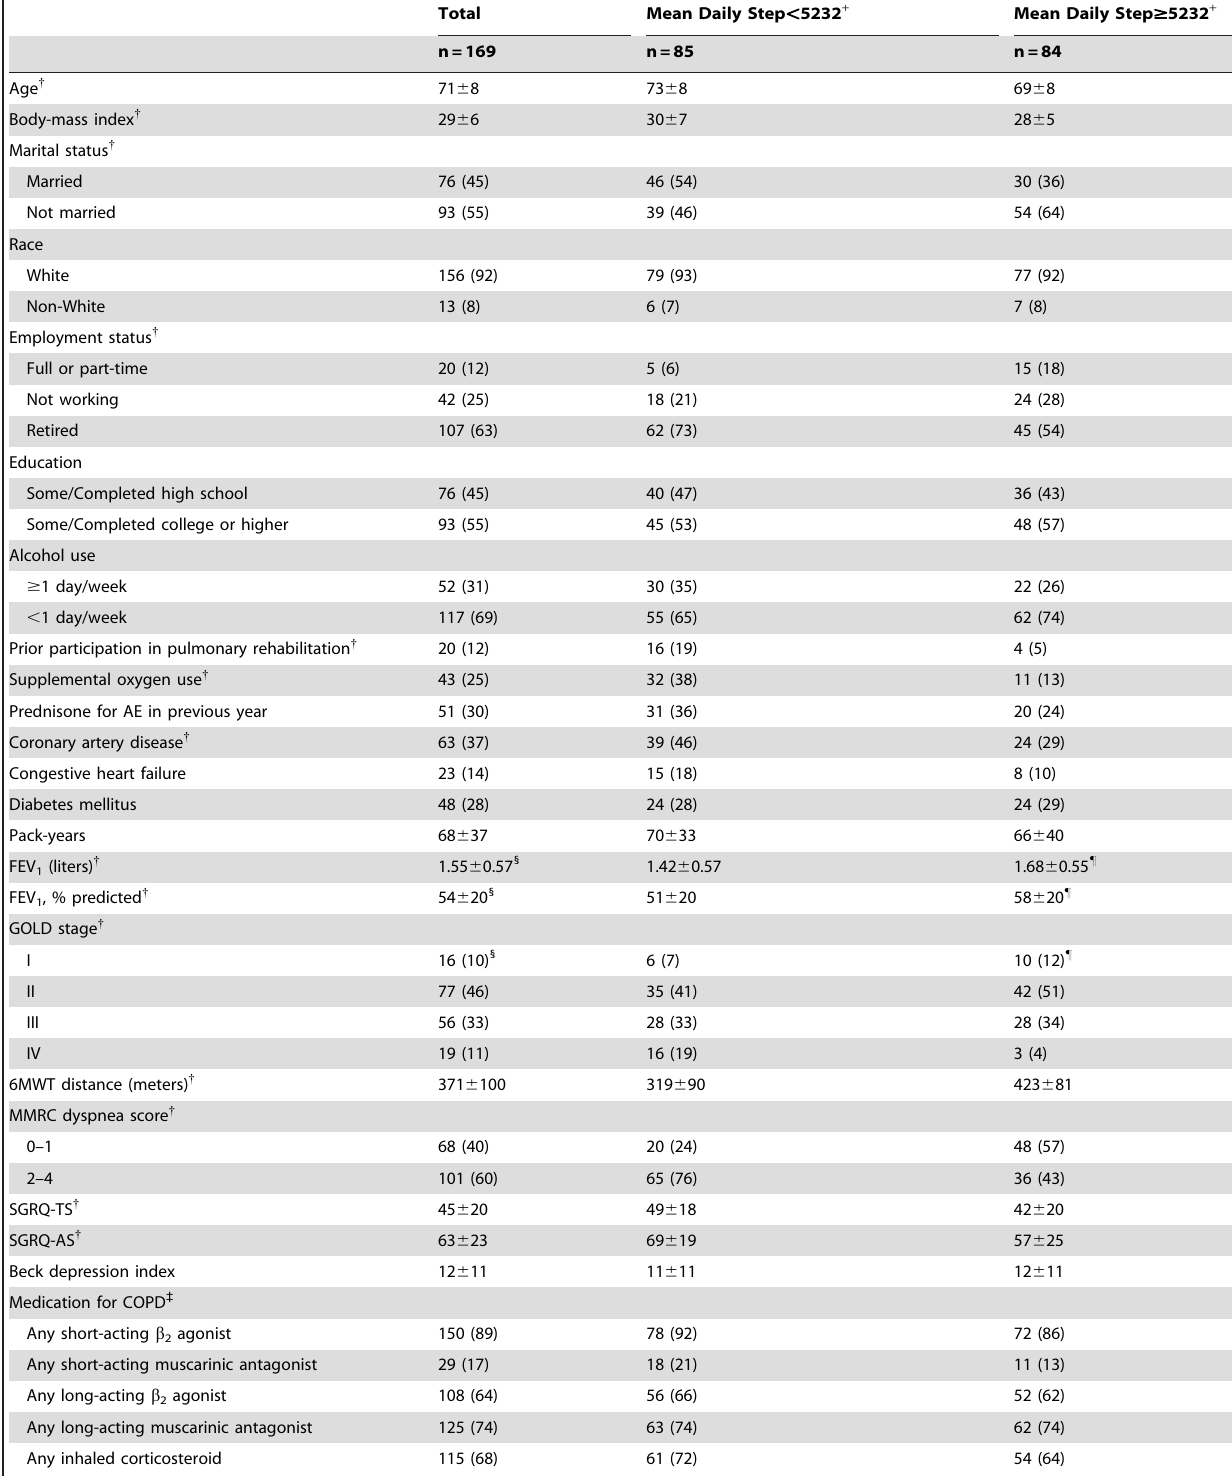
Table 1. Subject Characteristics.